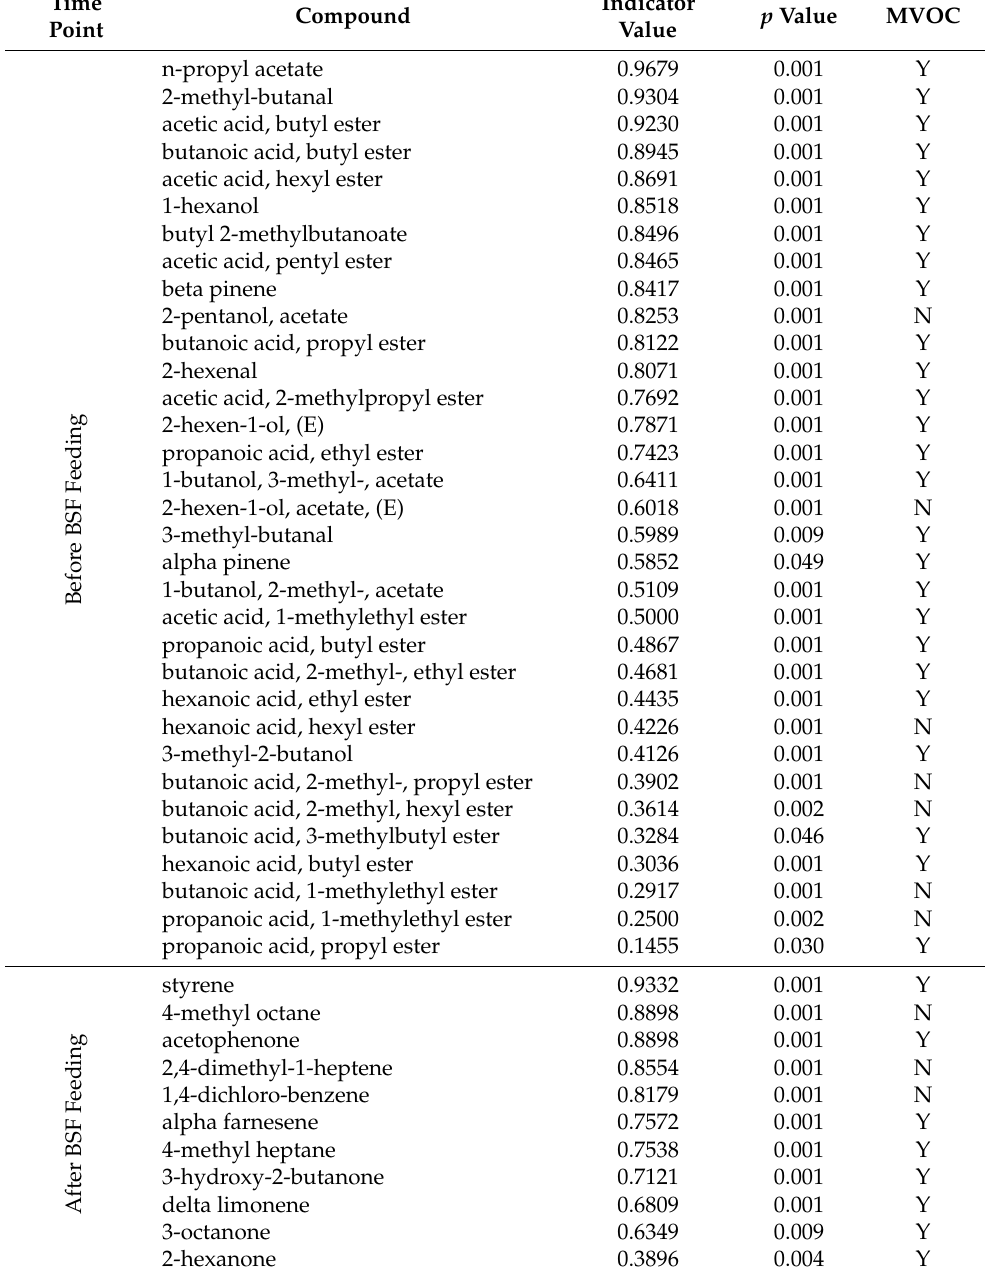
Table 2. Indicator VOCs for the two sampling time points (before and after feeding by BSF larvae), for all the six diet treatments combined. MVOC, microbial volatile organic compounds, Y, yes; N, no. Data are reported as indicator value, showing the relative frequency and relative abundance of each compound that can be considered as a measure of exclusiveness for a species in a